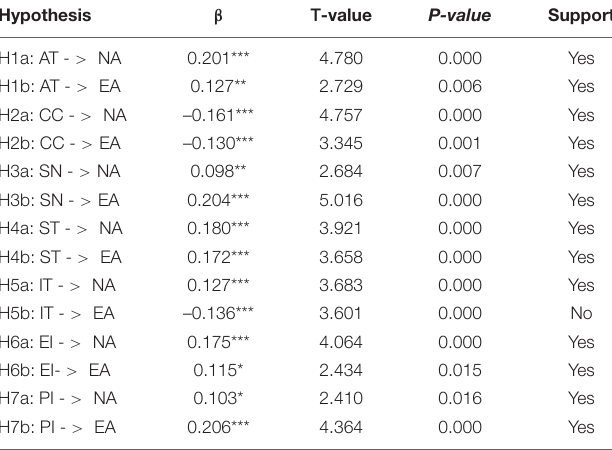
TABLE 5 | Results of algorithm and bootstrapping